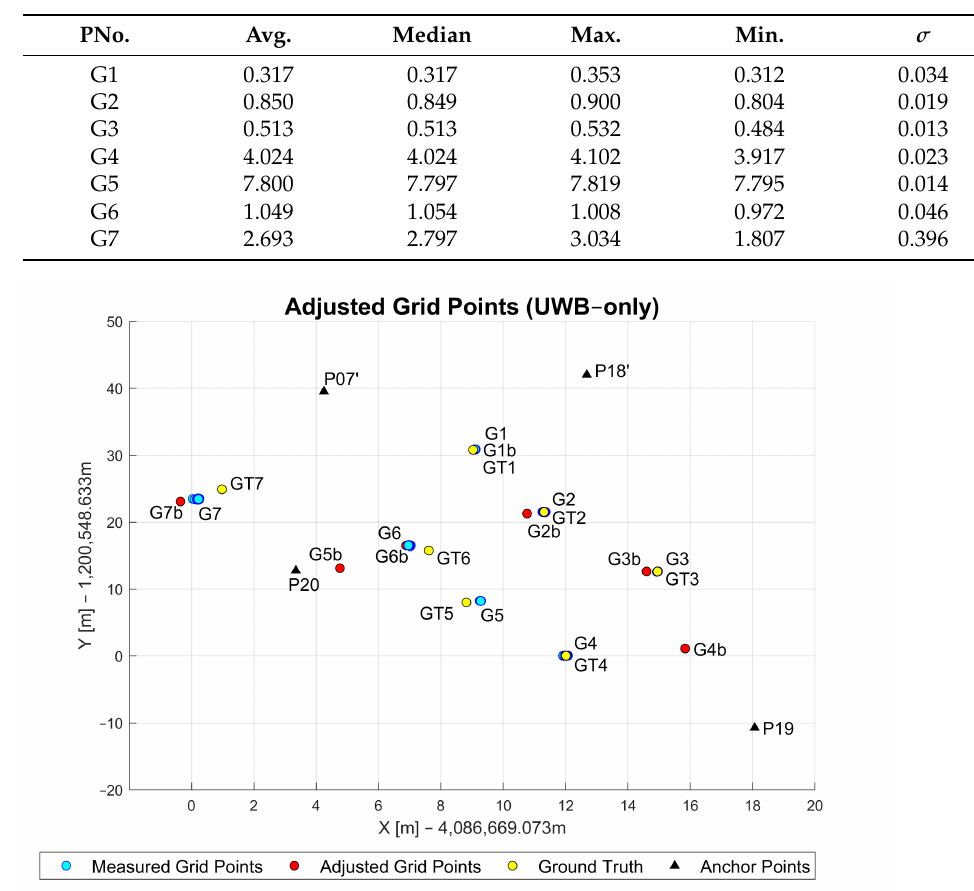
Figure 14. Adjusted, measured and ground truth grid point coordinates based on UWB-only